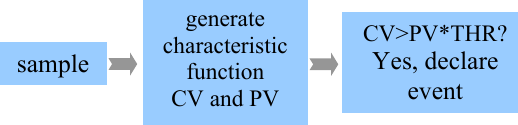
Fig. 3. Data flow diagram STA/LTA